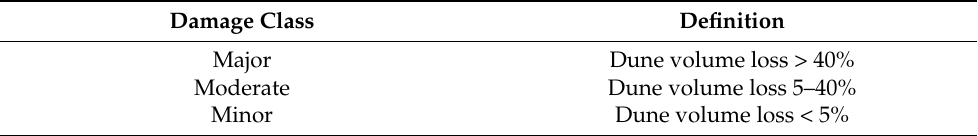
Table 3. Classification of storm-induced dune impacts based on quantitative